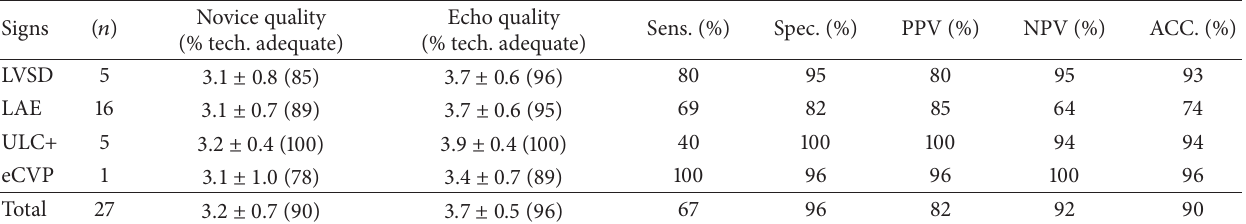
Table 2: Comparison of technically adequate CLUE views and diagnostic accuracy for each abnormality between guided-novice PUD and gold-standard